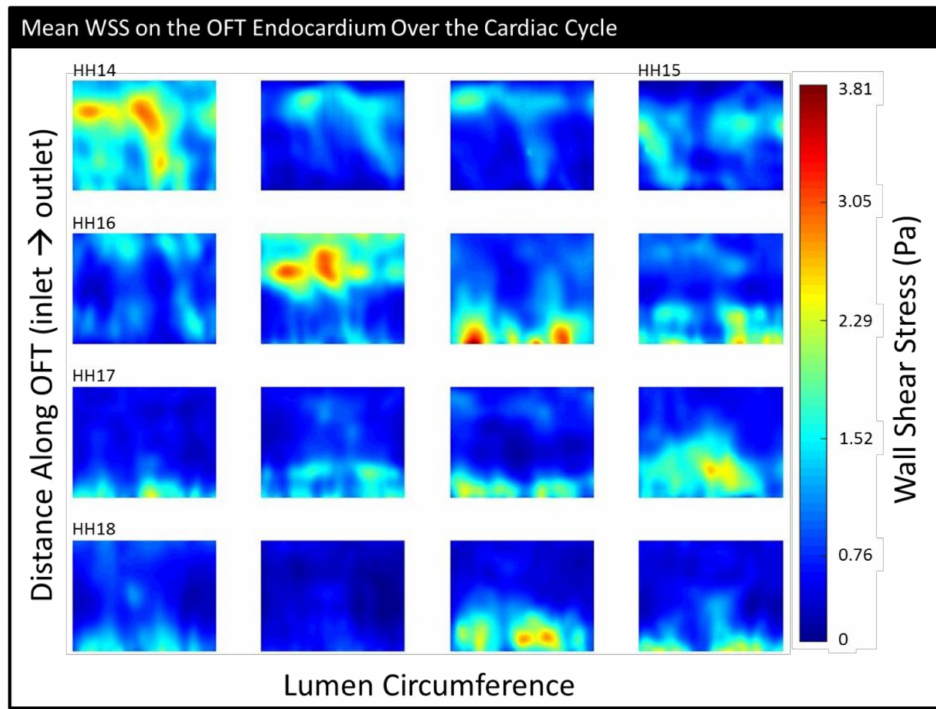
Figure 7. The mean (temporally averaged) wall shear stress over the simulated portion of the cardiac cycle shown on an “unrolled” endocardium surface (inlet at the bottom and outlet at top). The embryos have been ordered from youngest to oldest within each stage group and aligned in rows by